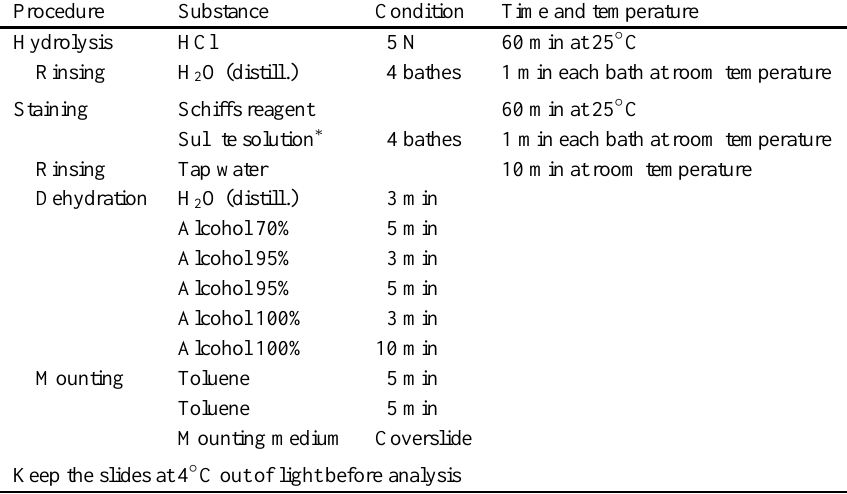
Protocol for Feulgen staining, following the final rinsing step after fixation (tested in the PRESS project